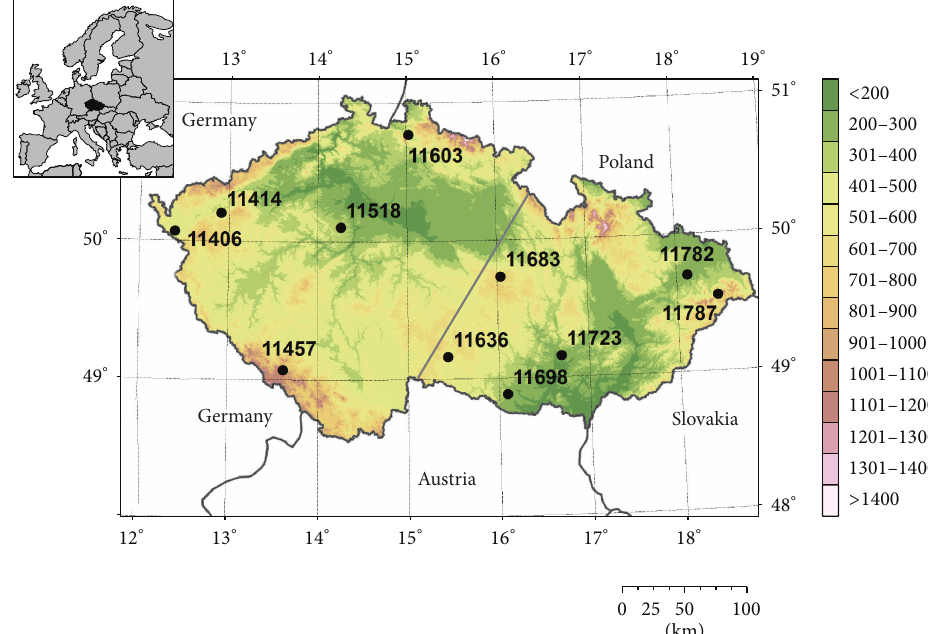
Figure 1: Area under study and locations of weather stations. The grey line shows a borderline between the western and eastern parts of the Czech Republic.